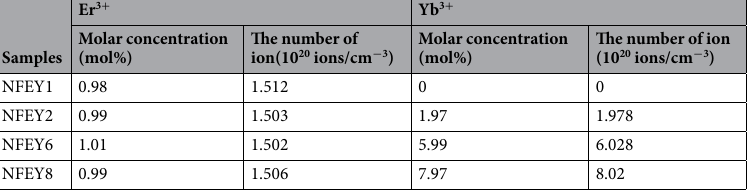
Table 1. The measured molar concentrations and the number of Er 3 + and Yb 3 + in Na 5 Lu 9 F 32